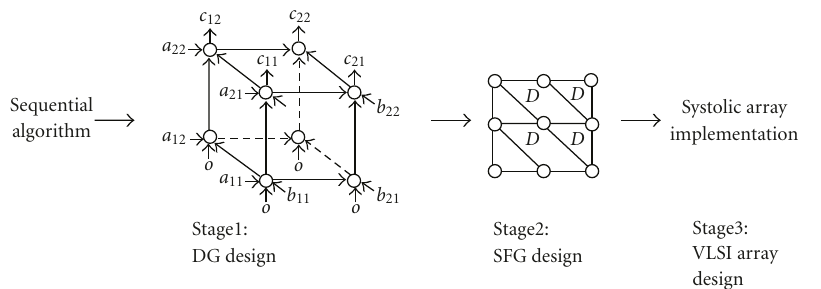
Figure 5: Mapping Design Methodology.